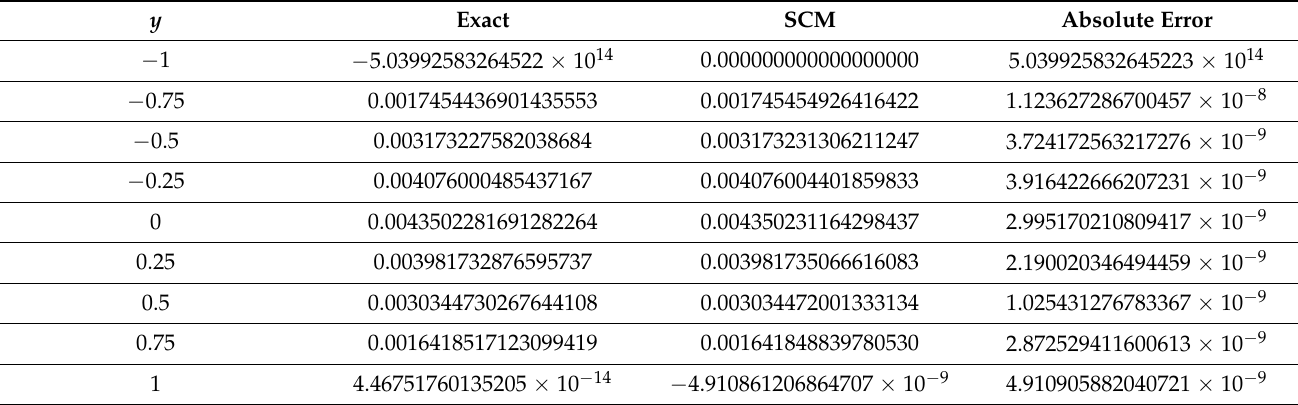
Table 1. Comparison of Exact solution and Numerical solution when α = 0 , β = 0.1, H = 1, γ = 1.